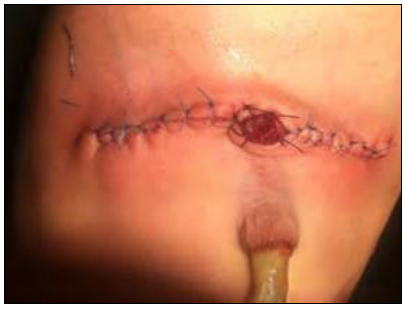
Figure 4: Antimesenteric bowel conduit after stoma formation.